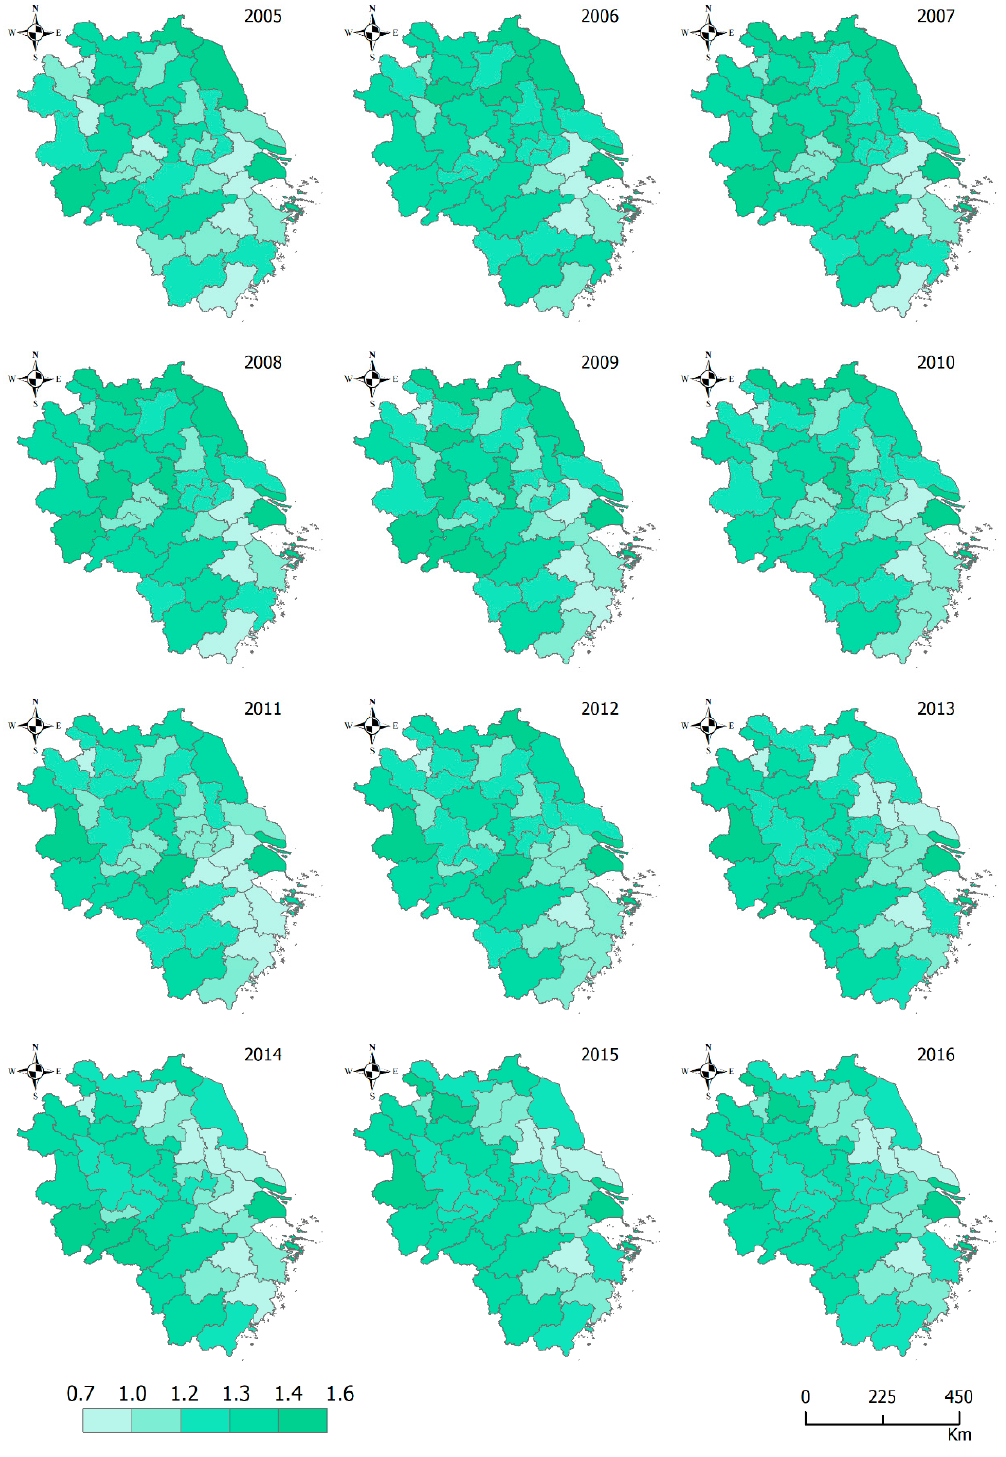
Figure 5. Spatiotemporal distribution of UV.